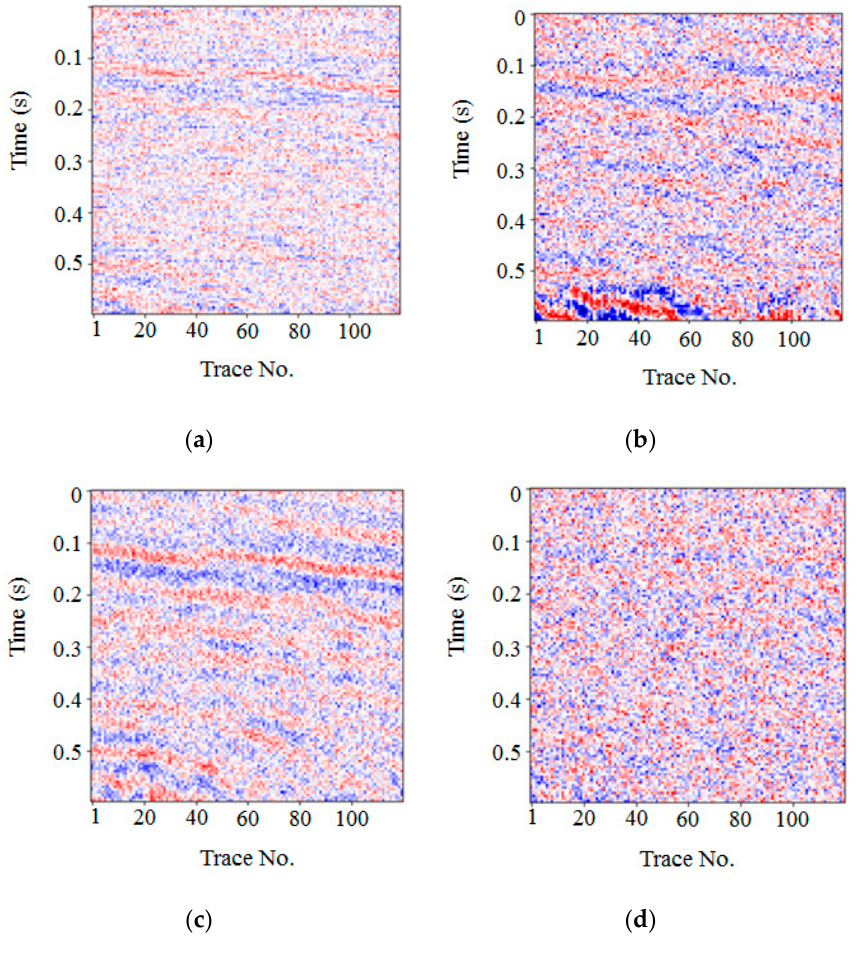
Figure 8. Comparison of noise removal from synthetic data. The noise was removed using ( a ) FXDECON, ( b ) MSSA, ( c ) wavelet transform, and ( d ) the proposed